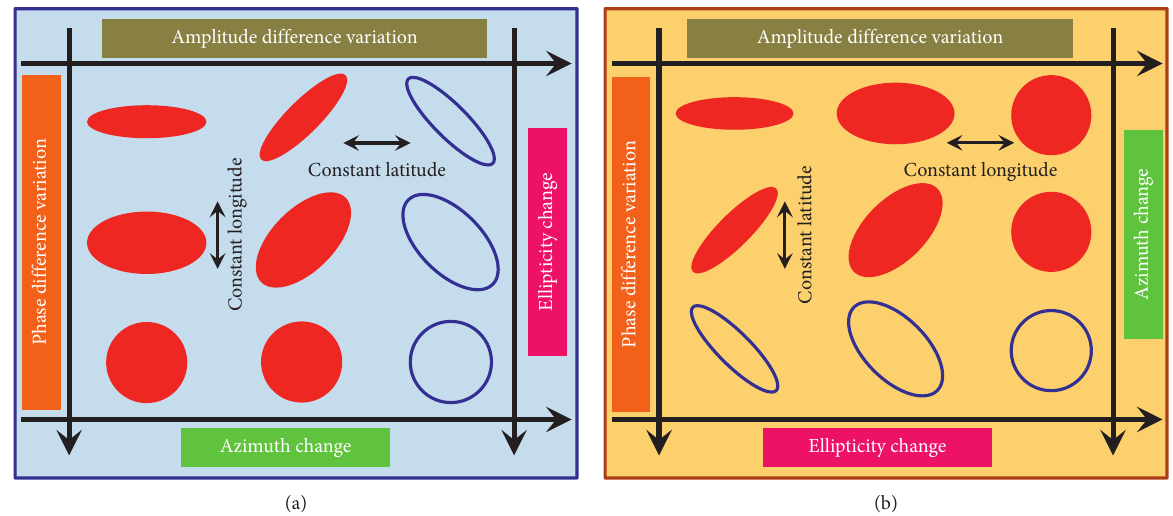
Figure 7: Role of amplitude and phase difference variation in azimuth and ellipticity in (a) linear and (b) circular